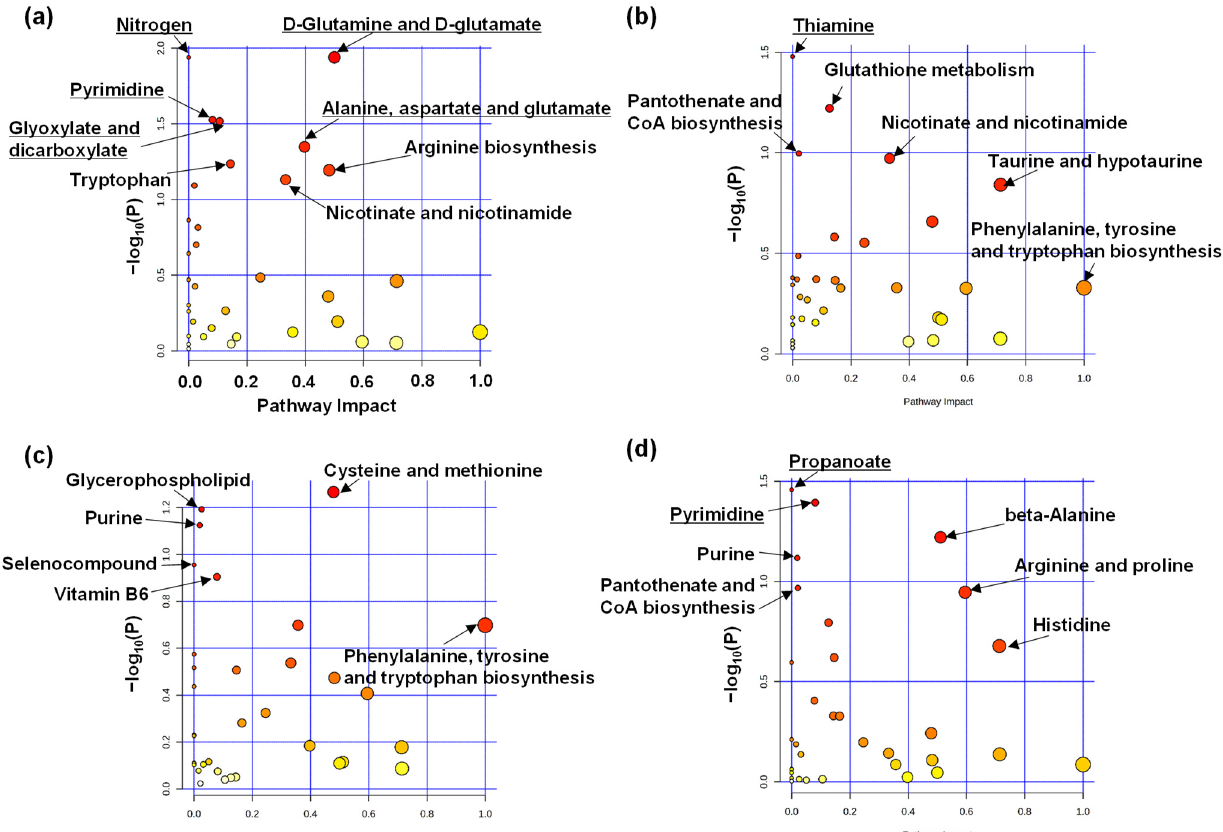
Figure 4. Pathway analysis results between depressive and nondepressive episode groups. Analysis results for ( a ) 3-, ( b ) 6-, ( c ) 9-, and ( d ) 12-month stays are shown. Metabolism is omitted from metabolite names. Underlined pathways indicate significant differences ( p < 0.05).